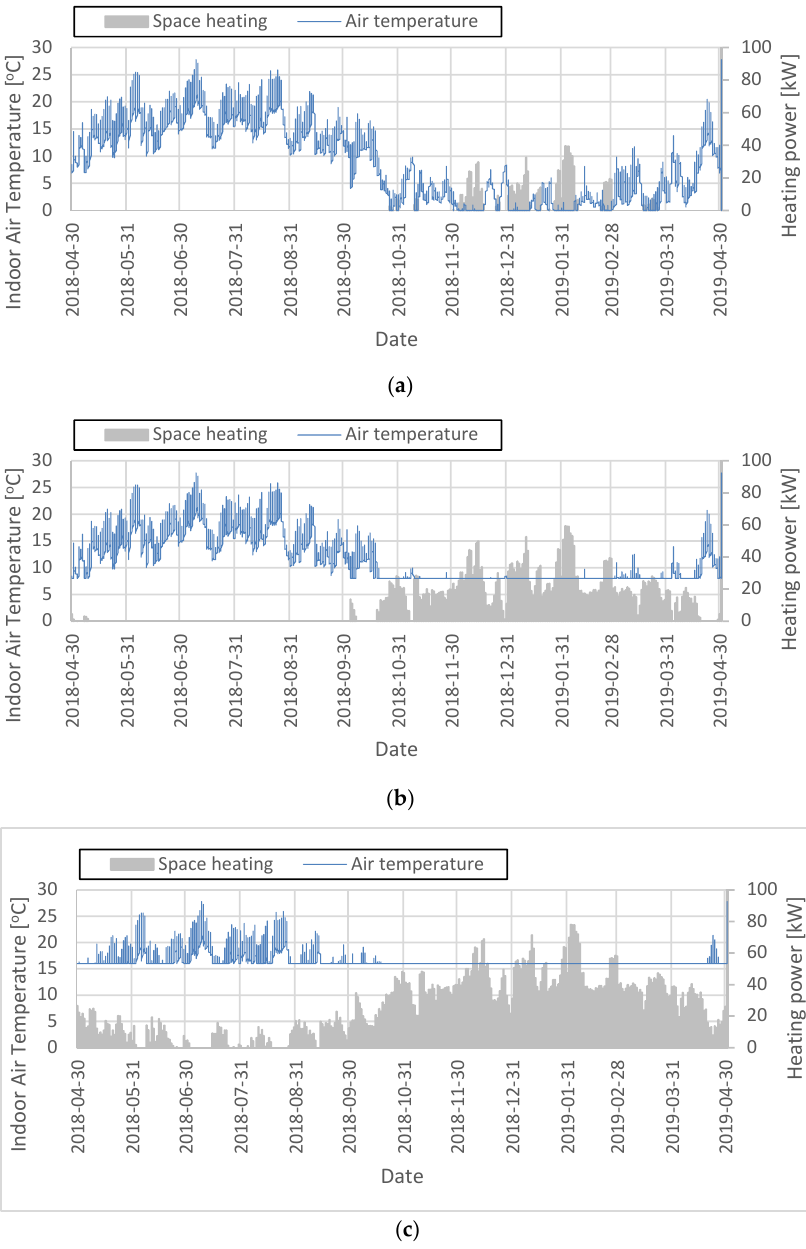
Figure 12. Energy demand for heating purposes against the background of internal air temperature: ( a )—variant 1; ( b )—variant 2; ( c )—variant 3.